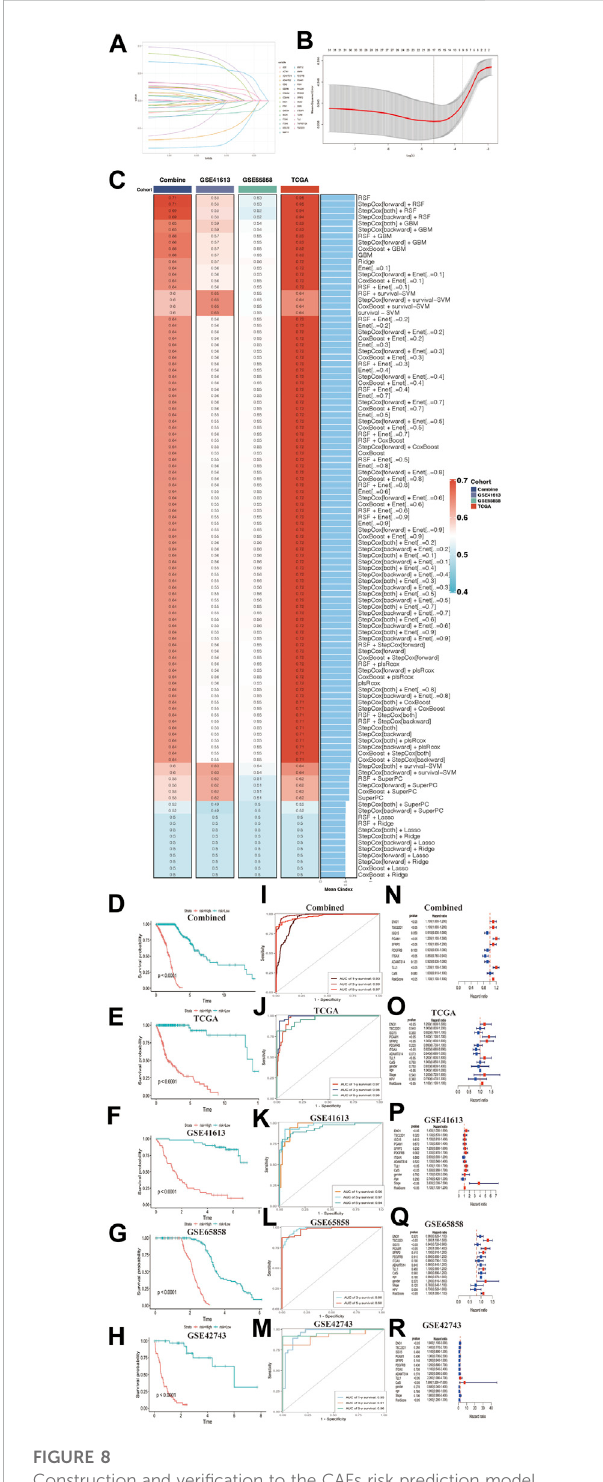
FIGURE 8 Construction and veri fi cation to the CAFs risk prediction model using machine learning methods (A) LASSO coef fi cient pro fi les of 31 cancer associated fi broblasts marker genes in Combined cohort. (B) 1000-time cross-validation for tuning parameter selection in the LASSO model; Combined cohort. (C) A total of 107 kinds of prediction models via machine learning and further calculated the C-index of each model across training and all validation cohorts. (D – H) Kaplan – Meier curves of overall survival according to the median risk score in Combined, TCGA-HNSC, GSE41613, GSE65858, and GSE42743 external validation cohorts. All log-rank p < 0.0001. ( Continued